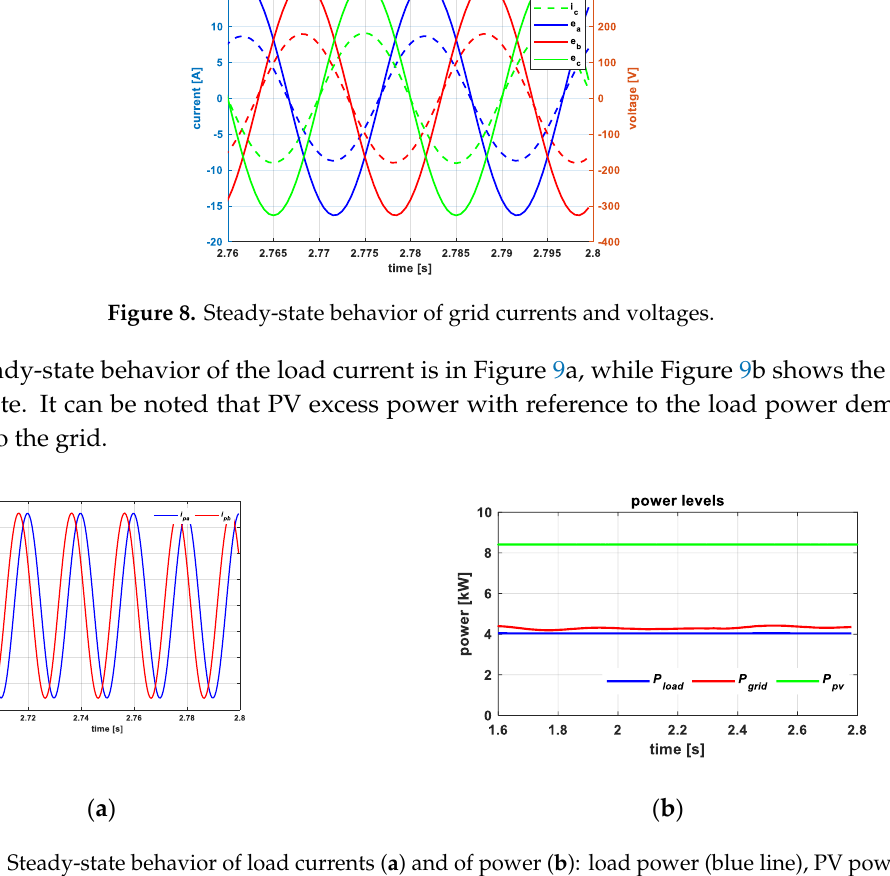
Figure 7. Time behavior of displacement angle α.